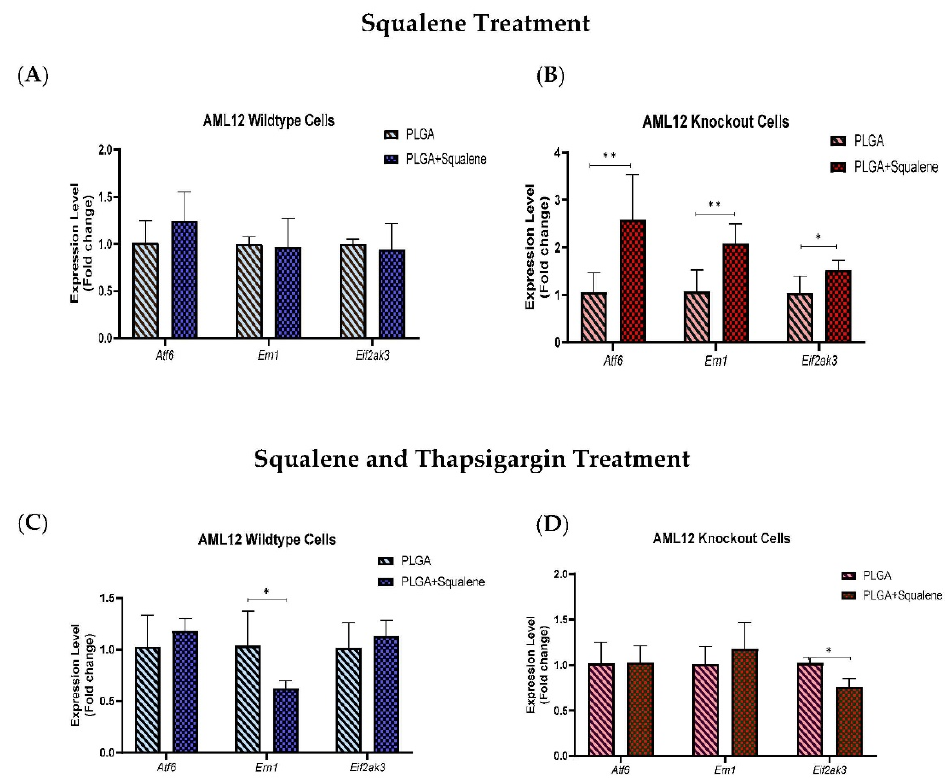
Figure 8. The mRNA expressions of Atf6 , Ern1 and Eif2ak3 in presence of squalene-PLGA nanoparticles under the ER stress challenge. After 72 h of treatment with 30 µM PLGA based squalene NPs, ( A ) the results of three genes ( Atf6 , Ern1 and Eif2ak3 ) represented a non-significant difference in WT cells. ( B ) Squalene with PLGA NPs induced a striking discrepancy in mRNA levels of Atf6 , Ern1 and Eif2ak3 in TXNDC5 knockout cells. In order to evaluate the protective activity of squalene-PLGA NPs, when the cells were treated with 12.5 nM thapsigargin for 24 h to produce ER stress, ( C ) wild-type cells showed a significant reduction in Ern1 mRNA rate, but no significant decline in Atf6 or Eif2ak3 mRNA levels. ( D ) TXNDC5 knockout cells revealed that the presence of squalene reduced Eif2ak3 expression when exposed to a compound that generates ER stress, but there was no difference in Atf6 and Ern1 expression. The two-way ANOVA and Mann–Whitney’s U-test were used in the data analysis; * p < 0.05, ** p < 0.01.